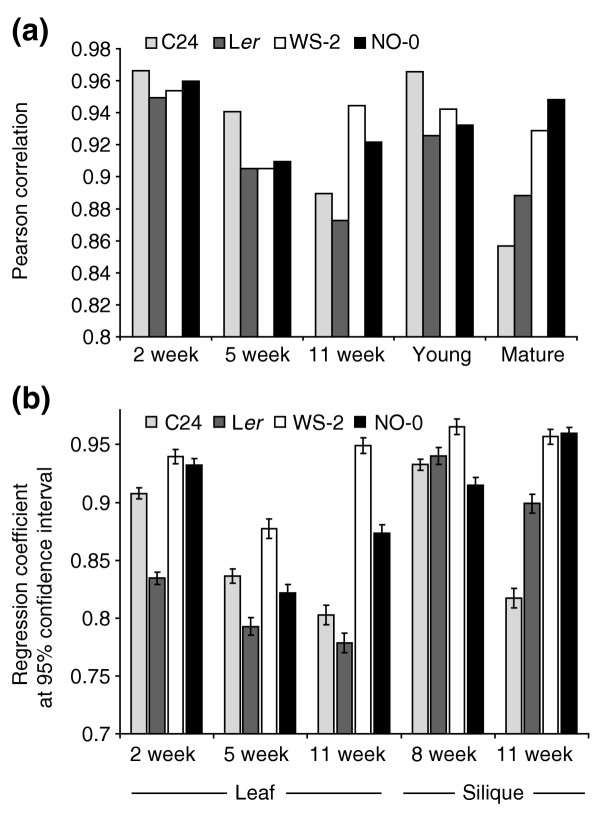
Correlations in transcription among five accessions during leaf and silique development. (a) The Pearson correlation coefficient for a given sample was calculated with nRHI for all the genes from each accession and the reference accession Col-0. Each bar represents the correlation of a particular accession as compared to Col-0 in the sample group. Note the common trend in reduction of the correlation during leaf and silique development for each organ. (b) The regression coefficient for a given sample was calculated with nRHI for all the genes from each accession (Y-values, regressor) and the reference accession Col-0 (X-values, predictor). Each bar represents the regression coefficient of a particular accession as compared to Col-0 in the sample group. The regression coefficient (b) was calculated as b = (ΣXiYi - (ΣXi)(ΣYi)/n)/(ΣXi2 - (ΣXi)2/n), where n is the total number of genes in either Col-0 or the sample to be compared (7,508 in this case). The error bar indicates the upper or lower limit of the 95% confidence interval for each of the given regression coefficients. The 95% confidence interval was calculated as b ± tα(2), (n-2)Sb, where tα(2), (n-2) is the t critical value at α = 0.05, two-tail, df = 7,506, and Sb is the standard deviation of b.